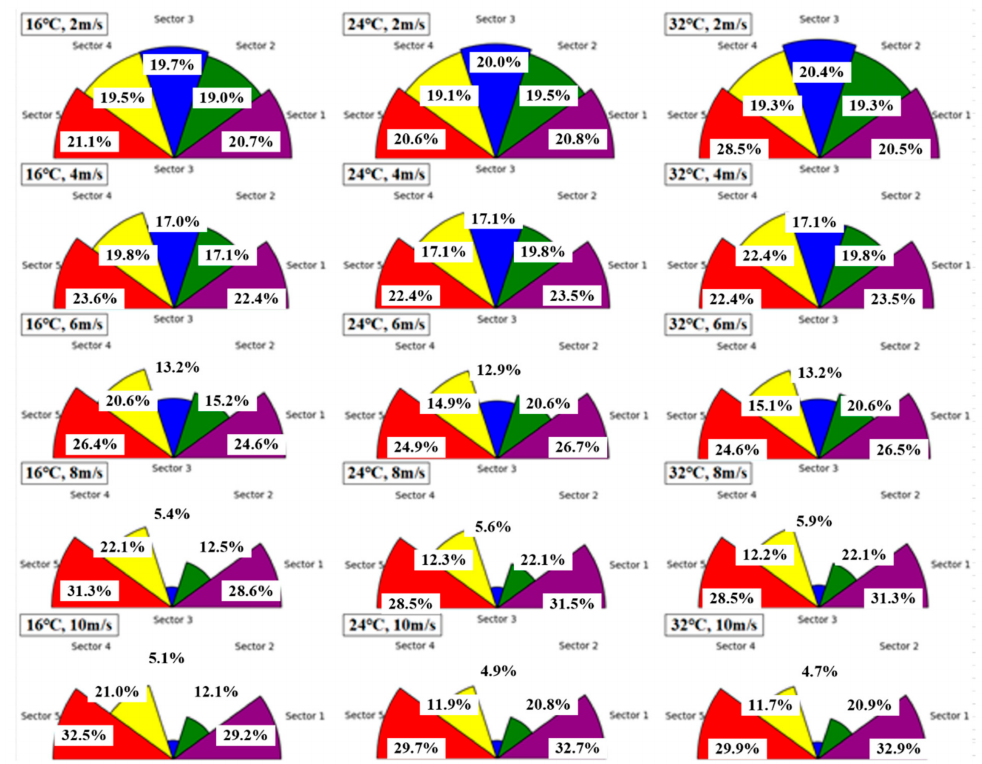
Figure 9. The optimal circulating cooling water distributions under different ambient conditions.